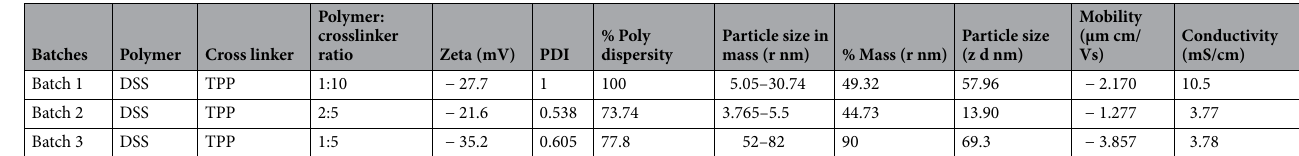
Table 1. Physical characterization of dextran sulfate sodium (DSS) nanoparticles. DSS dextran sulphate sodium, TPP tripolyphosphate, PDI poly dispersity index.